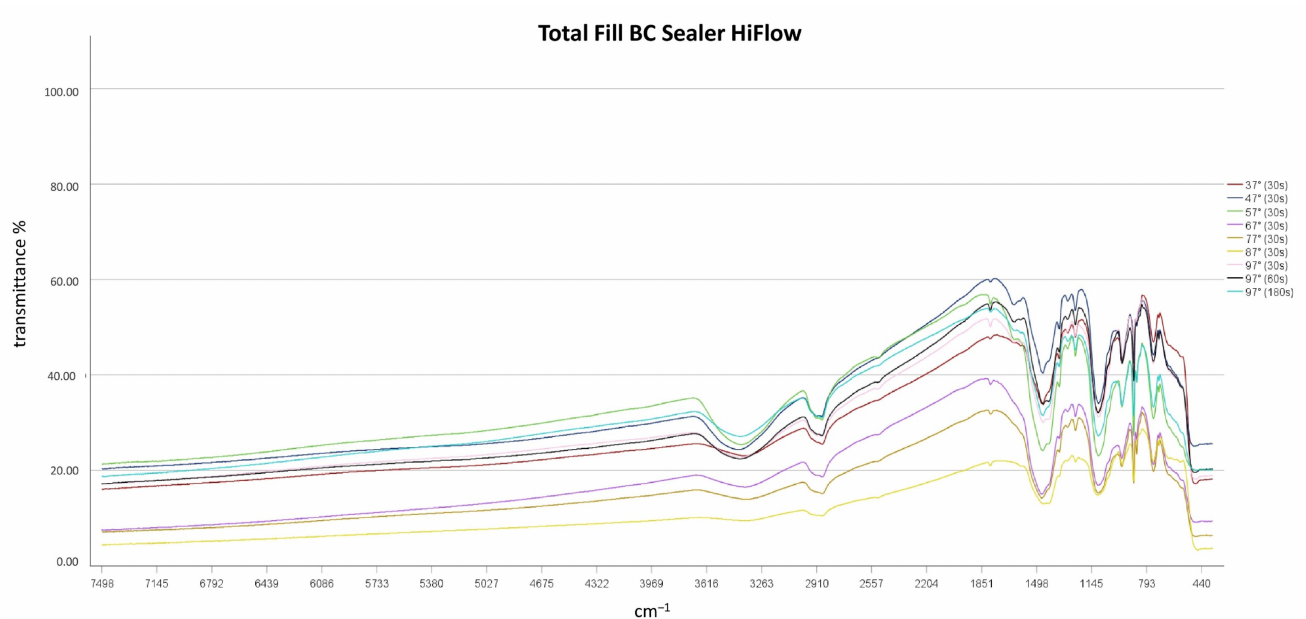
Figure 3. FT-IR spectroscopic plots of Total Fill BC Sealer HiFlow.